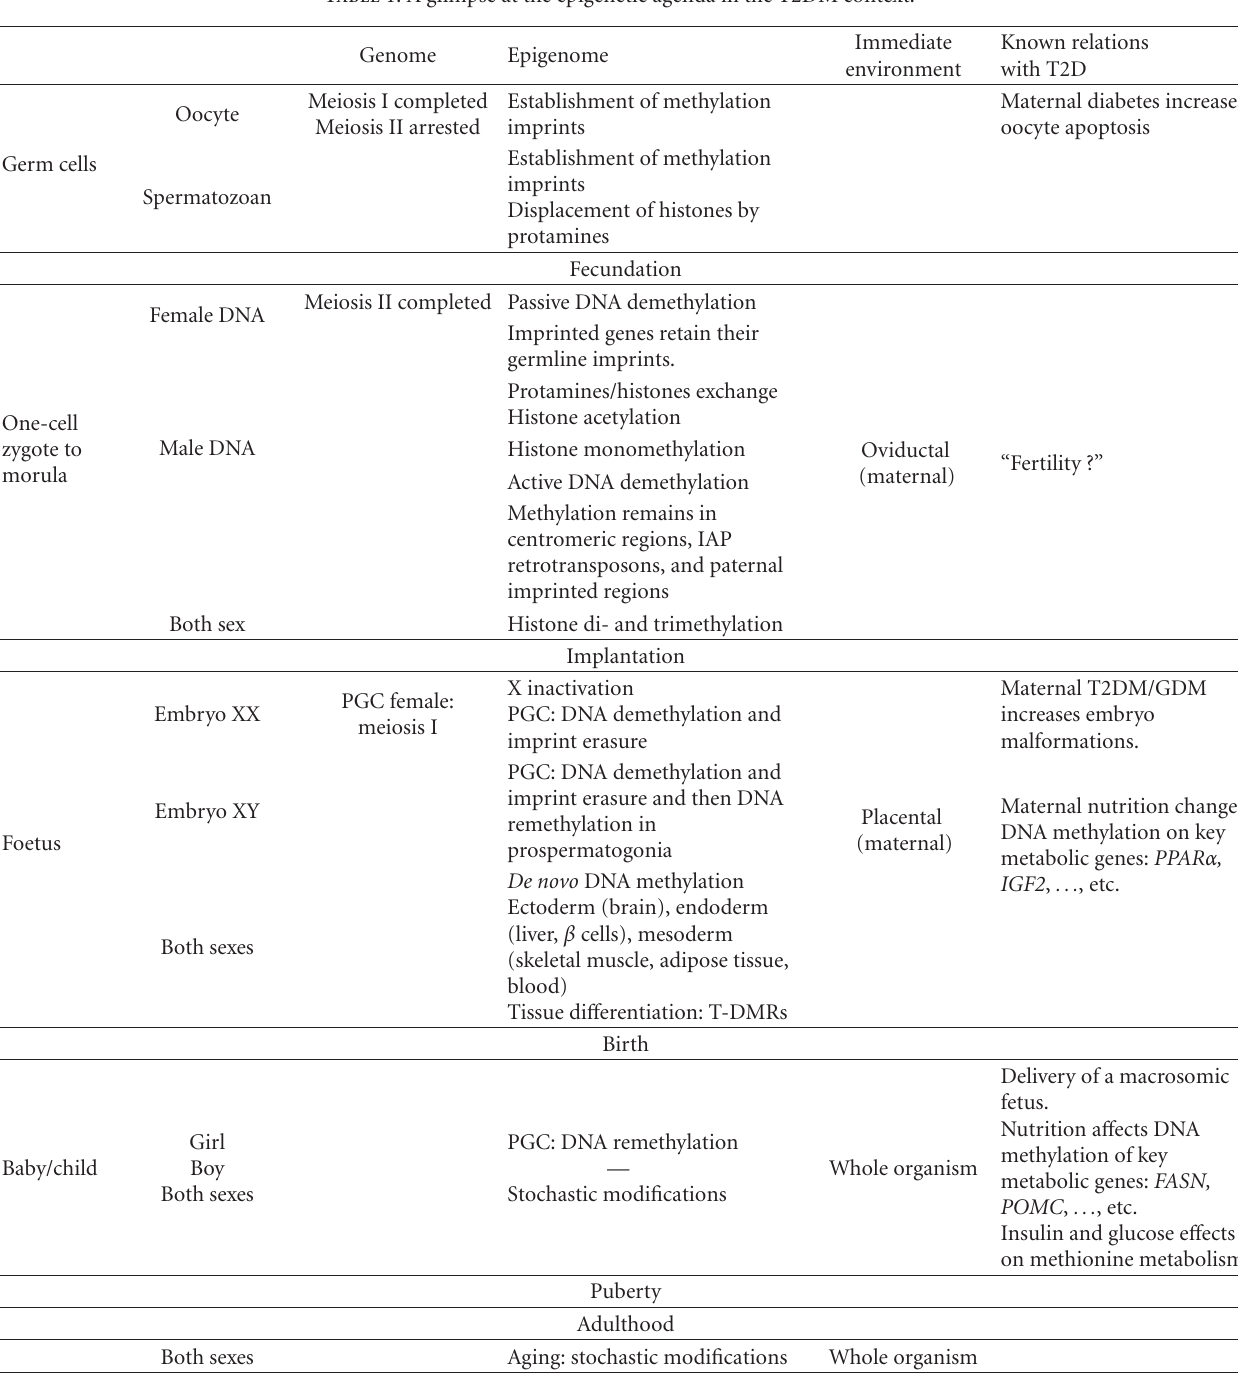
Table 1: A glimpse at the epigenetic agenda in the T2DM